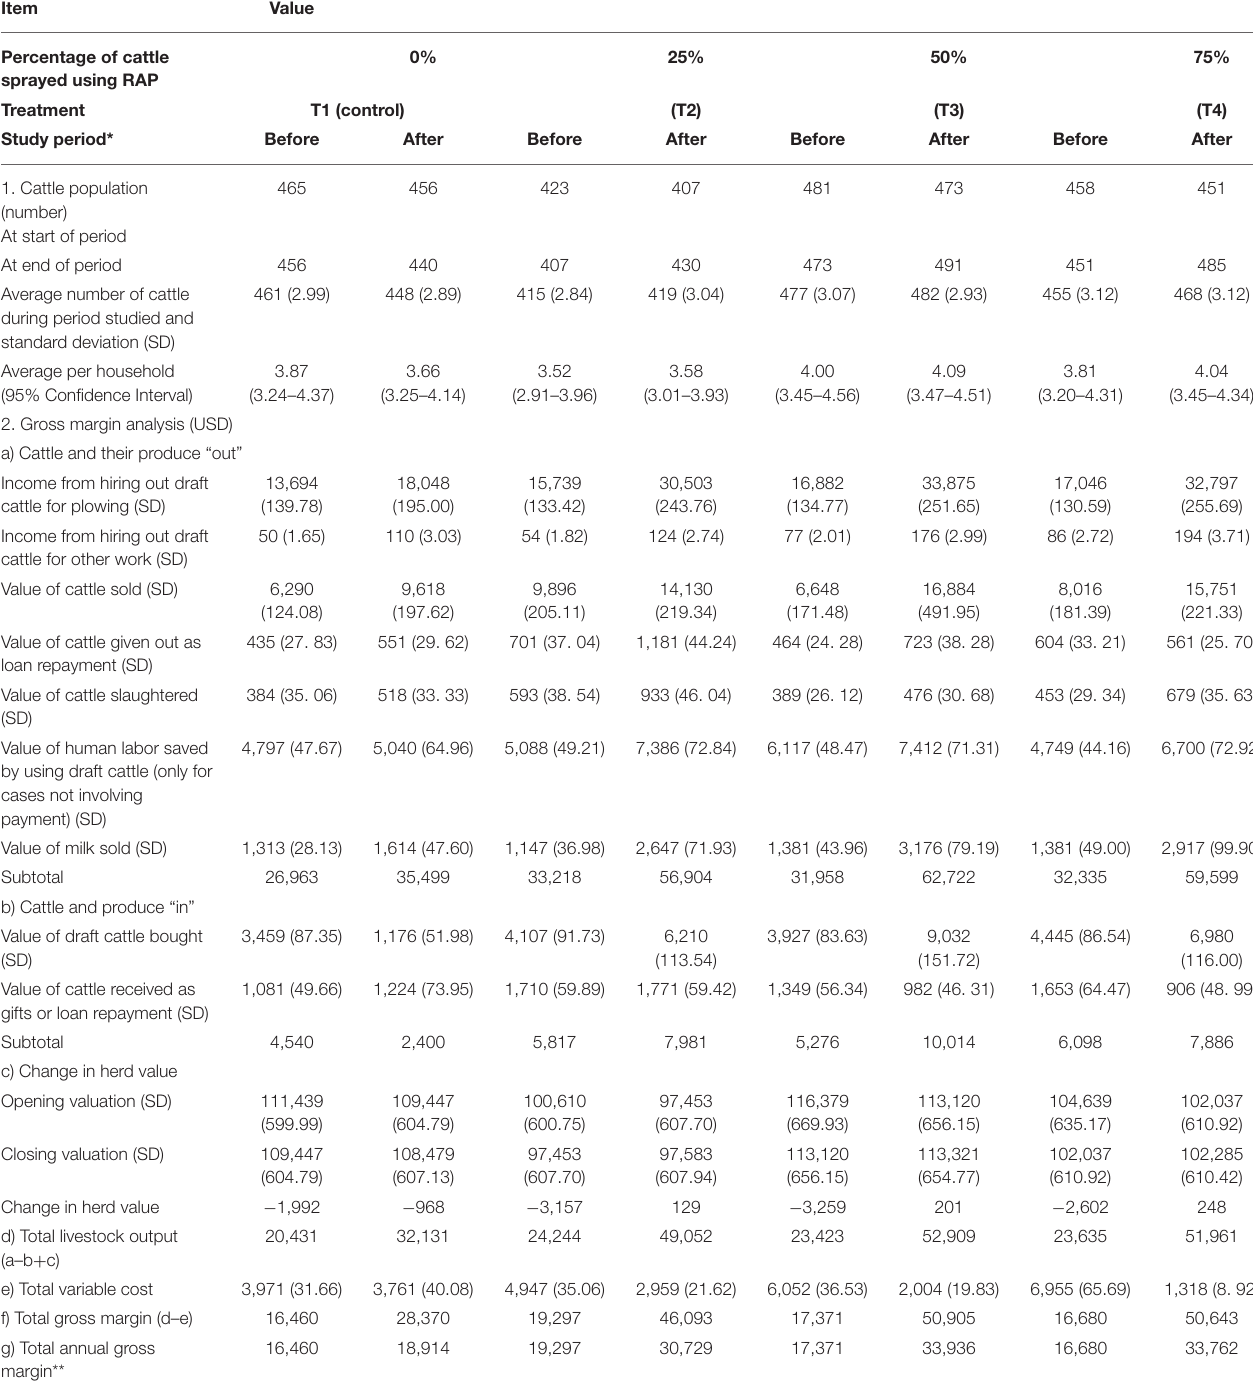
TABLE 3 | Cattle numbers and household gross margin for T1 to T4 during the 18-month